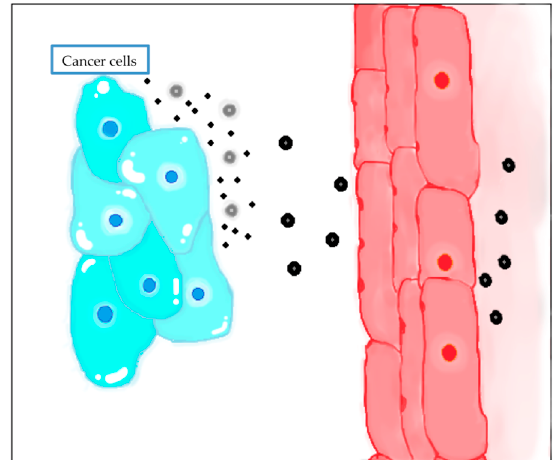
Figure 3. Schematic of the EPR e ff ect: NPs pass through the endothelial fenestrations and reach cancer cells.